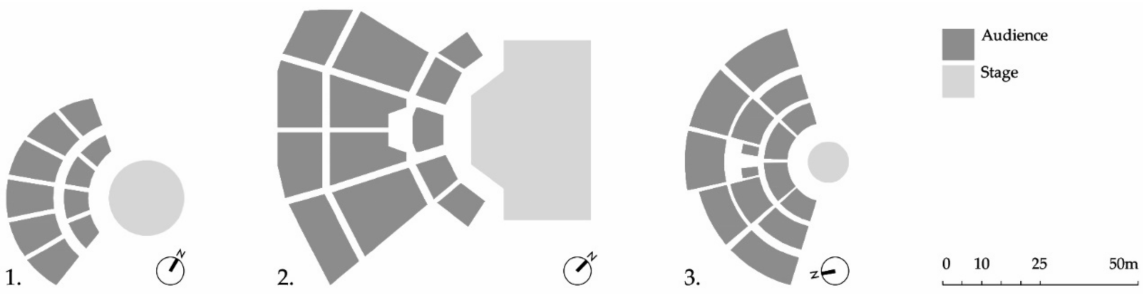
Figure 8. Plans of auditorium and stage in odeons: ( 1 ) Warsaw–Bemowo, ( 2 ) Kielce, ( 3 ) Płock. Original